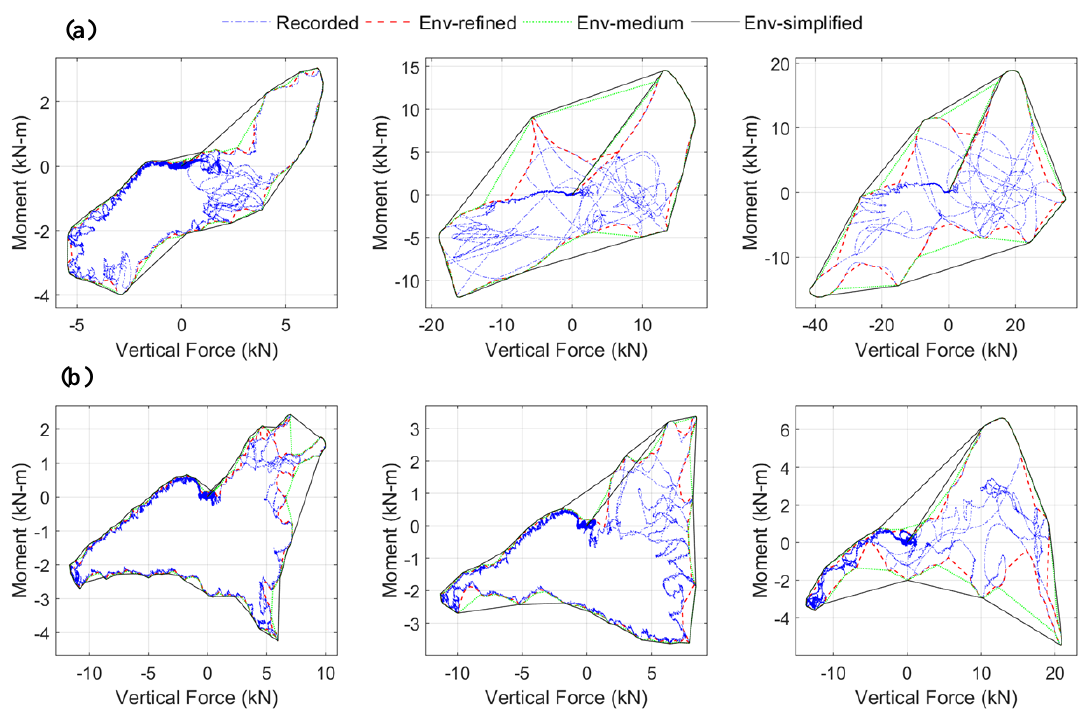
Figure 16. Demand diagrams of vertical force and moment for ( a ) solitary waves (top) with H = 0.42 m (left), H = 0.55 m (center) and H = 0.70 m (right), and ( b ) bores (bottom) with H = 1.0 m (left), H = 1.10 m (center) and H = 1.40 m (right).